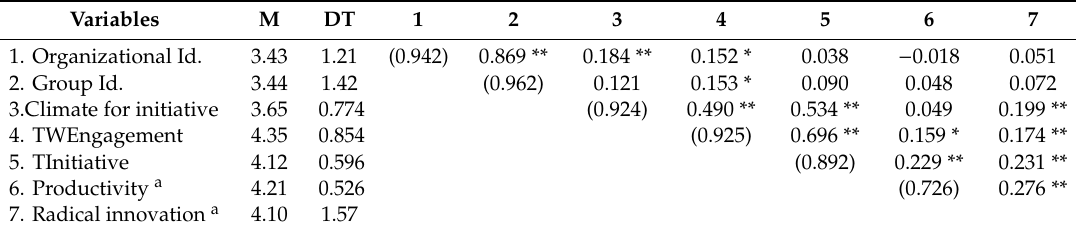
Table 2. Descriptive statistics and correlations.